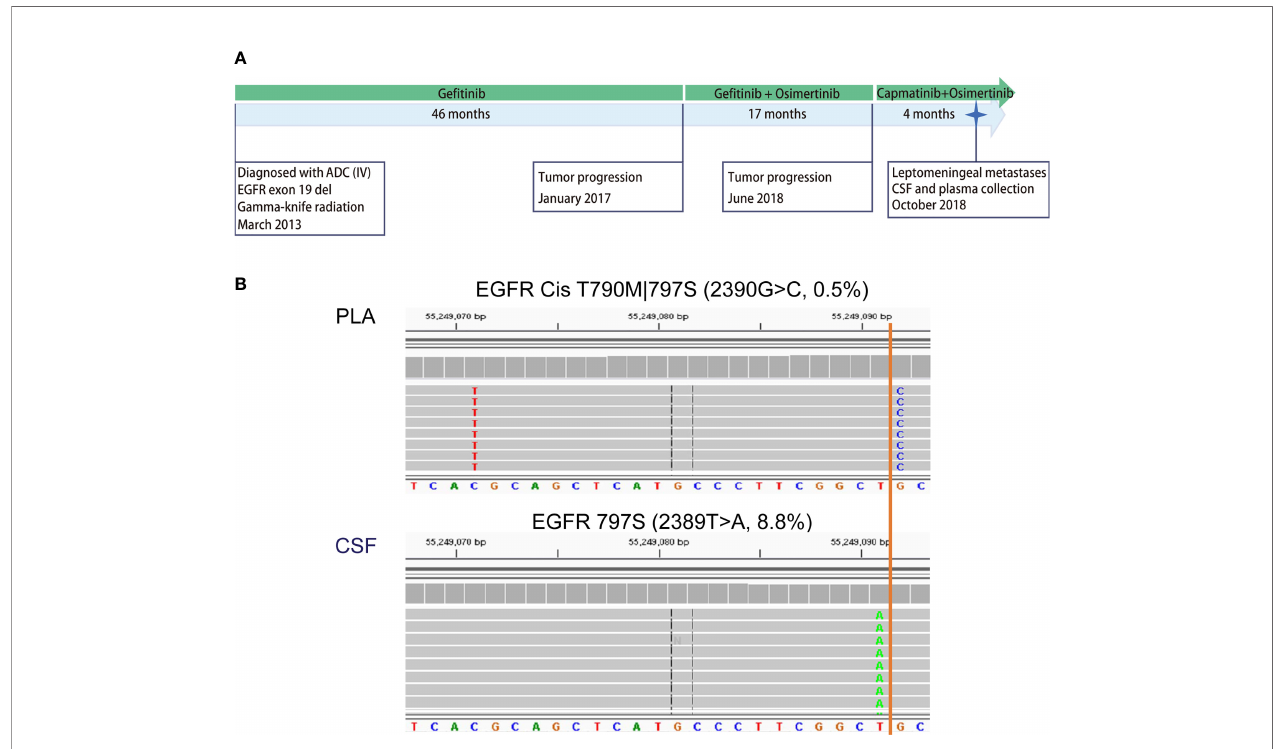
FIGURE 4 | Case analysis: distribution of EGFR-TKI-resistant mutations in P08. Patient P08 was exposed to both fi rst- (ge fi tinib) and third-generation (osimertinib) EGFR-TKIs before LM diagnosis. (A) Disease timeline. P08 was diagnosed with lung adenocarcinoma in March 2013 and received treatment with ge fi tinib, osimertinib, and capmatinib sequentially. In October 2018, he was diagnosed with leptomeningeal metastasis. CSF and matched peripheral blood were collected subsequently. (B) The mutation pro fi ling of CSF cfDNA and plasma cfDNA was performed using a next-generation sequencing (NGS) panel containing 180 genes. The raw reads for two types of EGFR mutations are shown. EGFR C797S 2390G>C was detected in the CSF in cis with T790M 2369C>T in plasma only (0.6%), not in CSF, while C797S 2389T>A was detected in CSF only